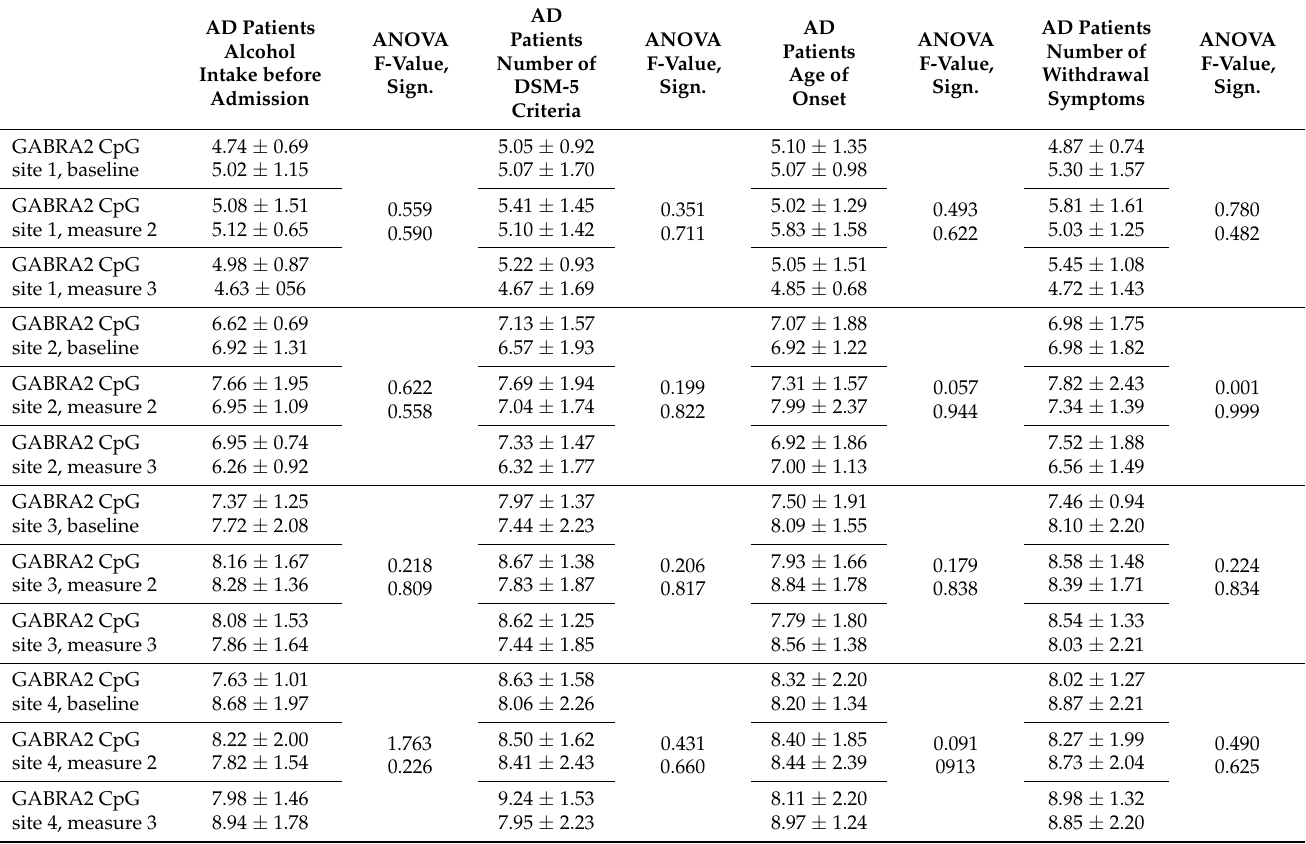
Table 4. Influence of Important Alcohol-Dependence Characteristics on GABRA2 CpG Methylation in Alcohol-Dependent Individuals (Median split: low vs. high, age as cofactor).